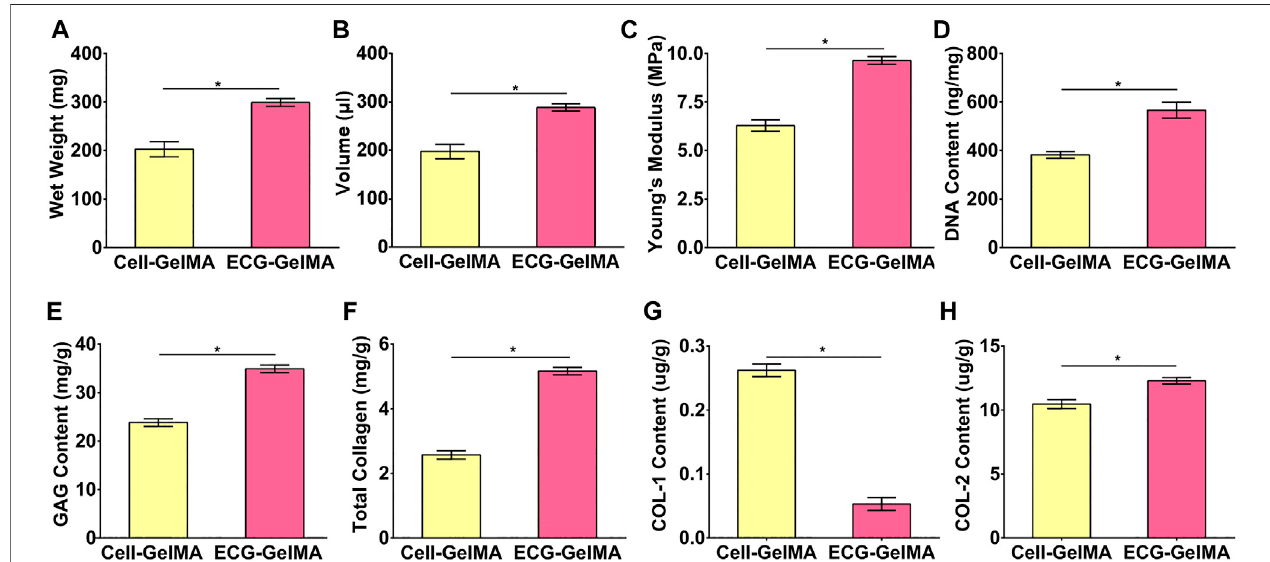
FIGURE 8 | Quantitative analysis of the regenerated cartilage in Cell-GelMA and ECG-GelMA groups after 12 weeks subcutaneously implantation in a goat. Quantitative analysis of wet weight (A) , volume (B) , Young ’ s modulus (C) DNA content (D) , GAG content (E) , total collagen (F) , COL-1 content (G) , and COL-2 content (H) in Cell-GelMA and ECG-GelMA groups. * p <